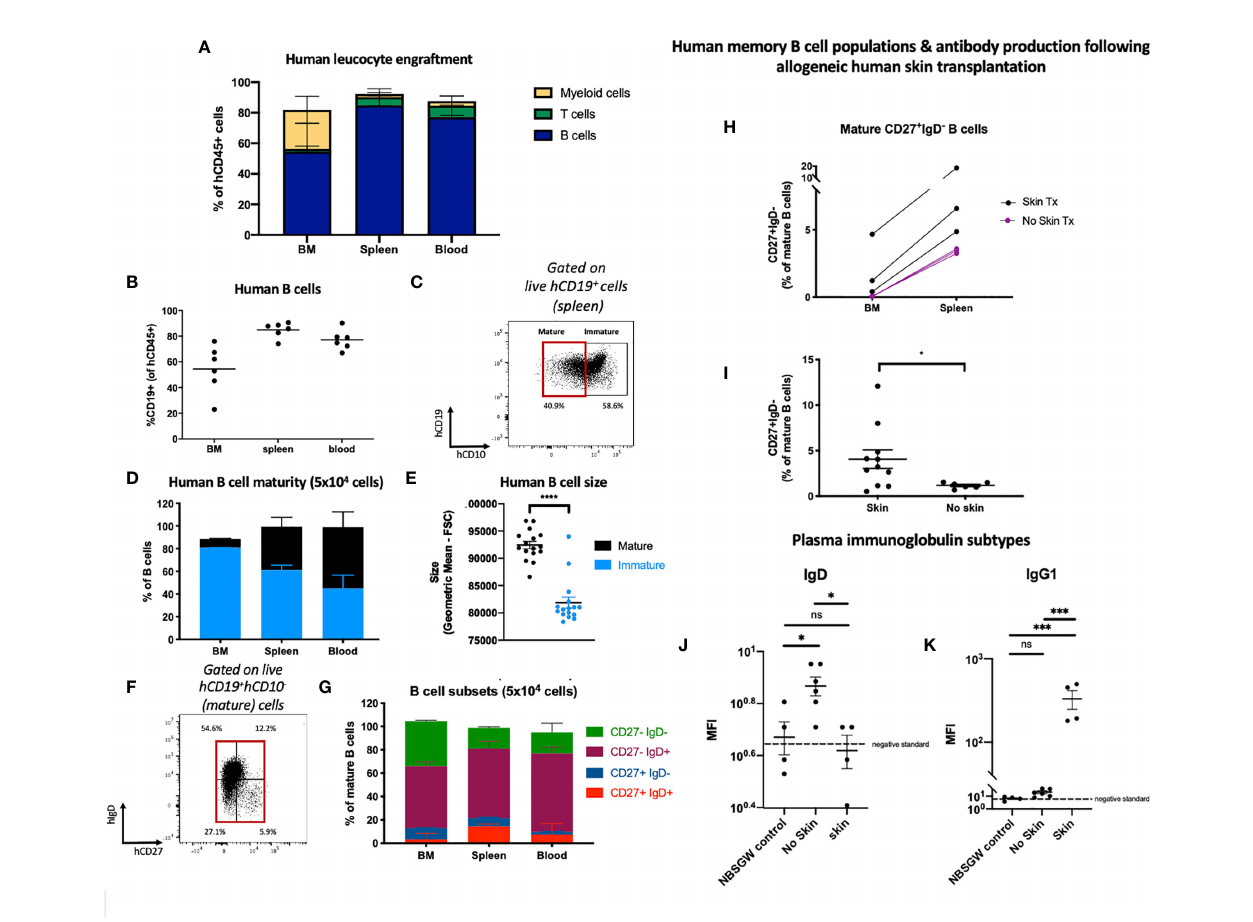
FIGURE 3 | Human B cell engraftment and development in HSPC-NBSGW mice. (A) Frequencies of human B cells, myeloid cells and T cells in the bone marrow, spleen and blood of HSPC-NBSGW mice 20-22 weeks after cell injection (50x10 3 cells). (B) Frequency of hCD19 + cells in the bone marrow (BM), spleen and peripheral blood (50x10 3 cells). Bars indicate median values. (C) Representative fl ow cytometric analysis of CD10 expression on human CD45 + CD19 + B cells in spleens harvested at 20-22 weeks. (D) Frequencies of mature (CD10-) and immature (CD10+) human B cells in the bone marrow, spleen and blood. (E) Sizes of mature vs immature human splenic B cells (determined by forward scatter (FSC). (F) Representative fl ow cytometric analysis and (G) corresponding frequencies of mature (CD10 - ) B cell subsets in the bone marrow, spleen and blood, based on IgD and CD27 expression. The red box indicates mature cells [as gated in (C) ]. (H) Frequencies of IgD-negative memory B cells in the femurs and spleens of HSPC-NBSGW mice which received allogeneic split-thickness human skin grafts 11 weeks after humanization and were sacri fi ced at the time of skin rejection (skin Tx) or 100 days after transplantation (no skin Tx). (I) Frequencies of class-switched memory B cells in the spleens of mice which did (skin) and did not (no skin) receive allogeneic split-thickness human skin grafts. (J, K) Geometric mean fl uorescence intensity (MFI) of plasma (J) human IgD and (K) human IgG1 in NBSGW (control), HSPC-NBSGW (no skin) and human skin-transplanted HSPC-NBSGW (skin) mice. Dashed lines represent negative standards (background fl uorescence). Bars represent median + IQR (A, D, G) , mean + SEM (E, I) and median (H) values. Statistical signi fi cance was assessed using the paired t test (D) , two-tailed Mann-Whitney test (I) , and ordinary one-way ANOVA with Tukey ’ s multiple comparisons test (J, K) (*p<0.05; ***p<0.001; ****p<0.0001; ns